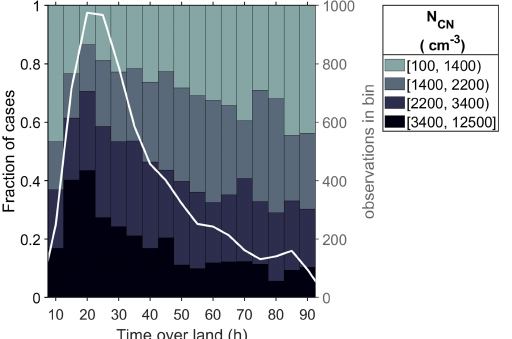
Figure 3. Fractions of measured condensation nuclei ( N CN ; sized ∼ 10nm and larger) number concentrations in four different value groups in air masses divided into 5h time-over-land bins. The white line and the right y axis show the number of observations in each bin. Six outliers more than 6 mean absolute deviations (MADs) from the mean were excluded (between 12500 and 19000cm − 3 ). The ranges are based on data percentiles, with the value group roughly representing the 0th–25th, 25th–50th, 50th–75th, and 75th– 100th percentiles. Note that this means that the range is not equal between groups.